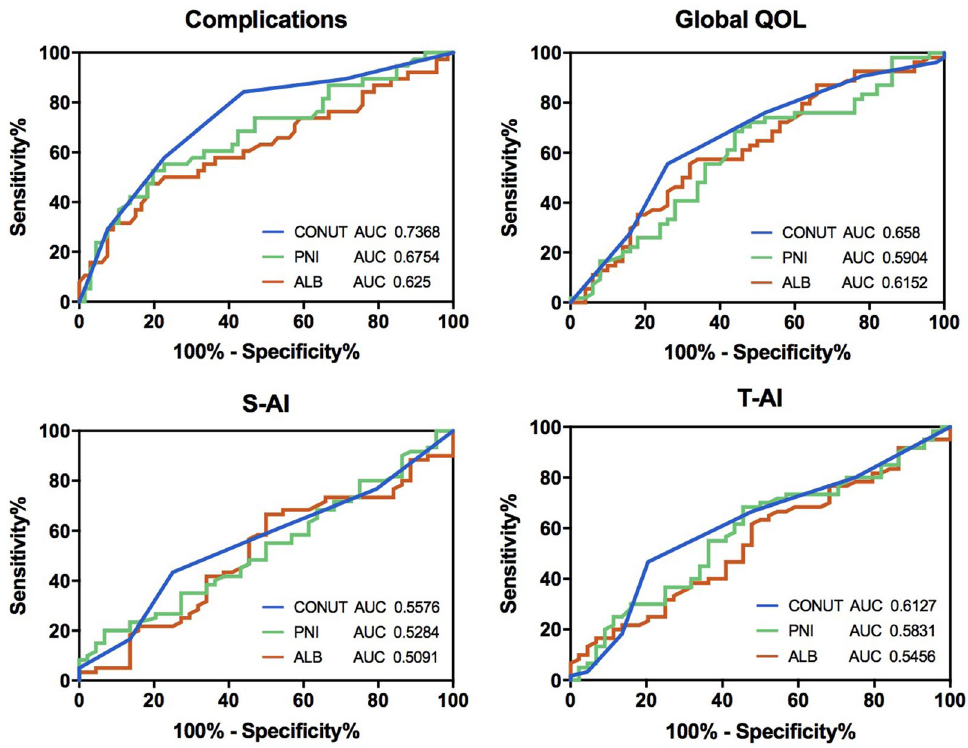
Figure 2. Horizontal comparison of the values of CONUT, PNI, and ALB in complications, global QoL, S-AI and